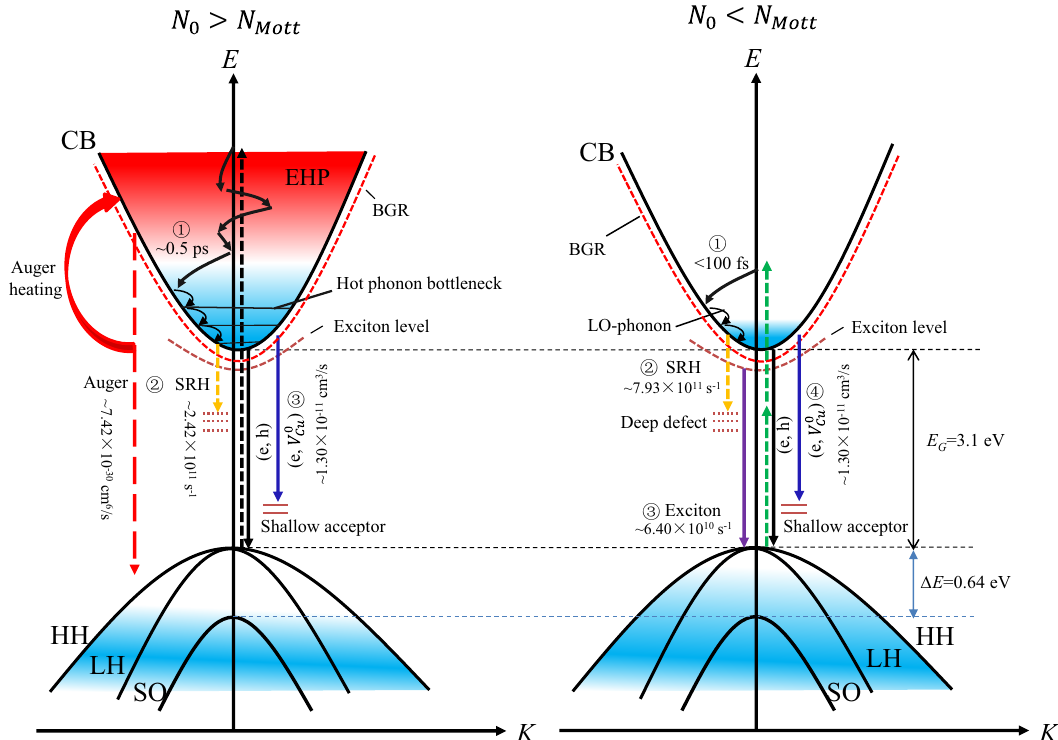
Fig.10|SchematicillustrationofcarrierdynamicsinCuIthin fi lm. Theleftpanelandtherightpanelrepresentthecaseswithexcitationdensity( N 0 )largerandlessthan the Mott density ( N Mott ),